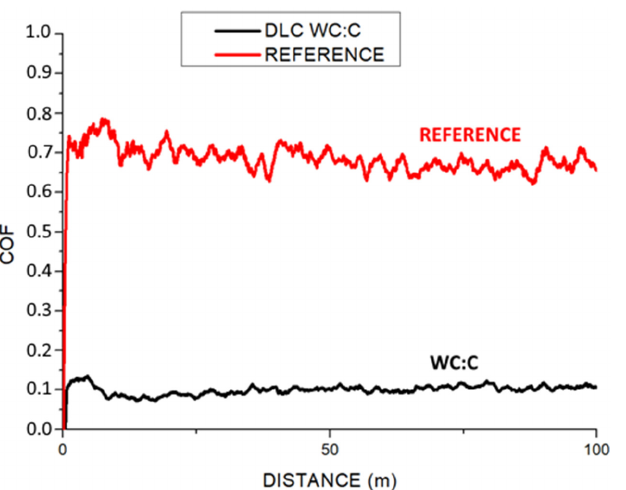
Figure 9. Friction coefficients of the reference sample and DLC WC:C coating under 5 N.